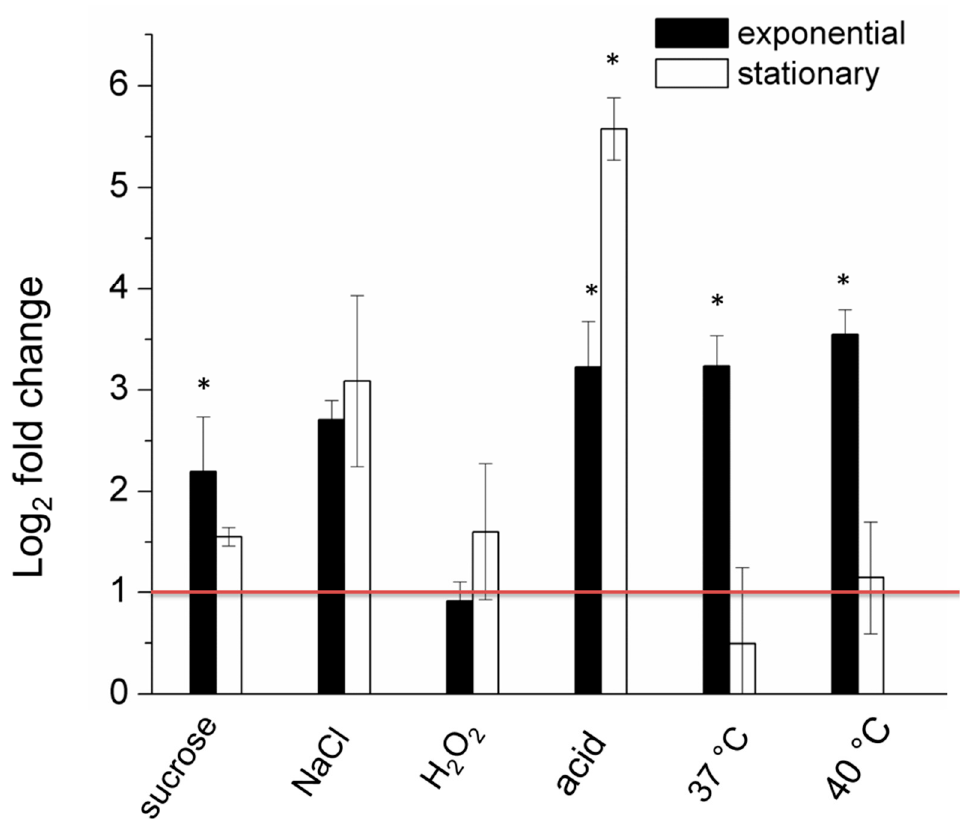
Figure 3. The relative log2 fold change of the expression levels of the lon gene in the D. solani cells under stressful conditions analyzed by qPCR. The data correspond to the means ± S.D. of three di ff erent samples, including three technical replicates. A red horizontal line indicates a relative two-fold increase in expression level. * indicates statistically significant (95% confidence interval) fold change in expression level according to the REST 2009 software.